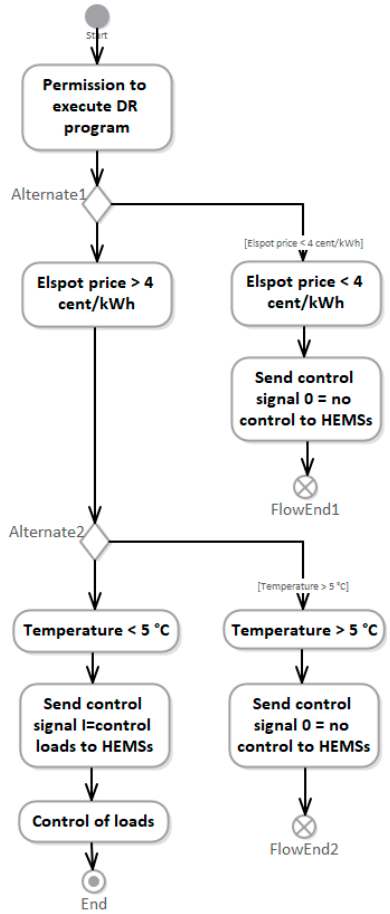
Figure 13. Demand response in the Sundom Smart Grid—activity diagram of the demand response for ancillary services TUC.